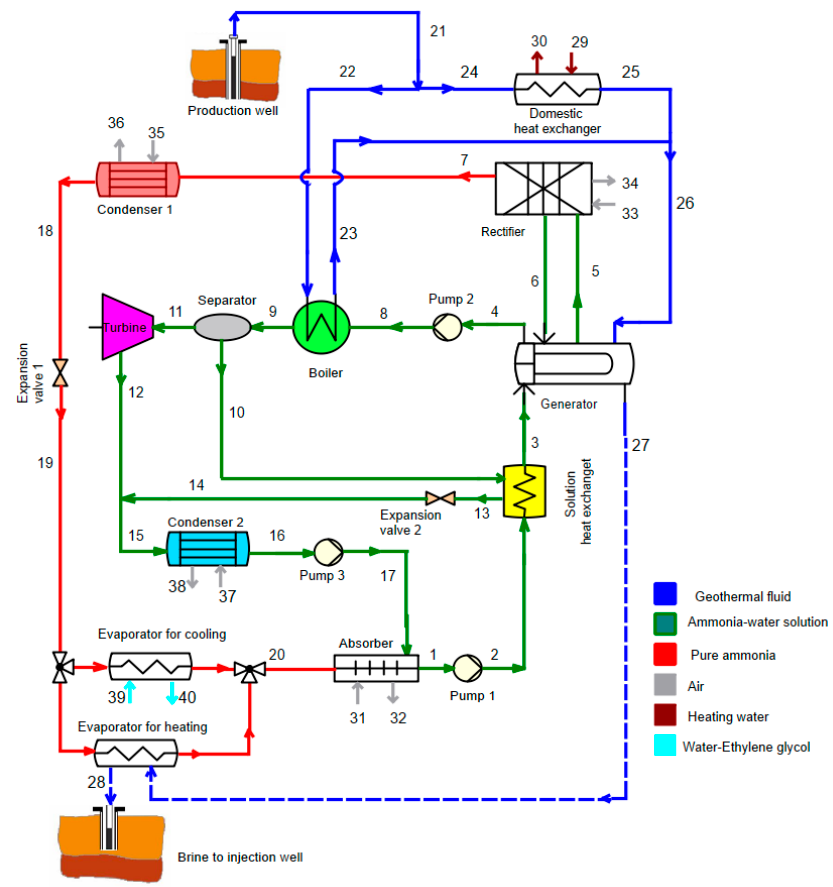
Figure 1. Schematic diagram of the proposed tri-generation system.